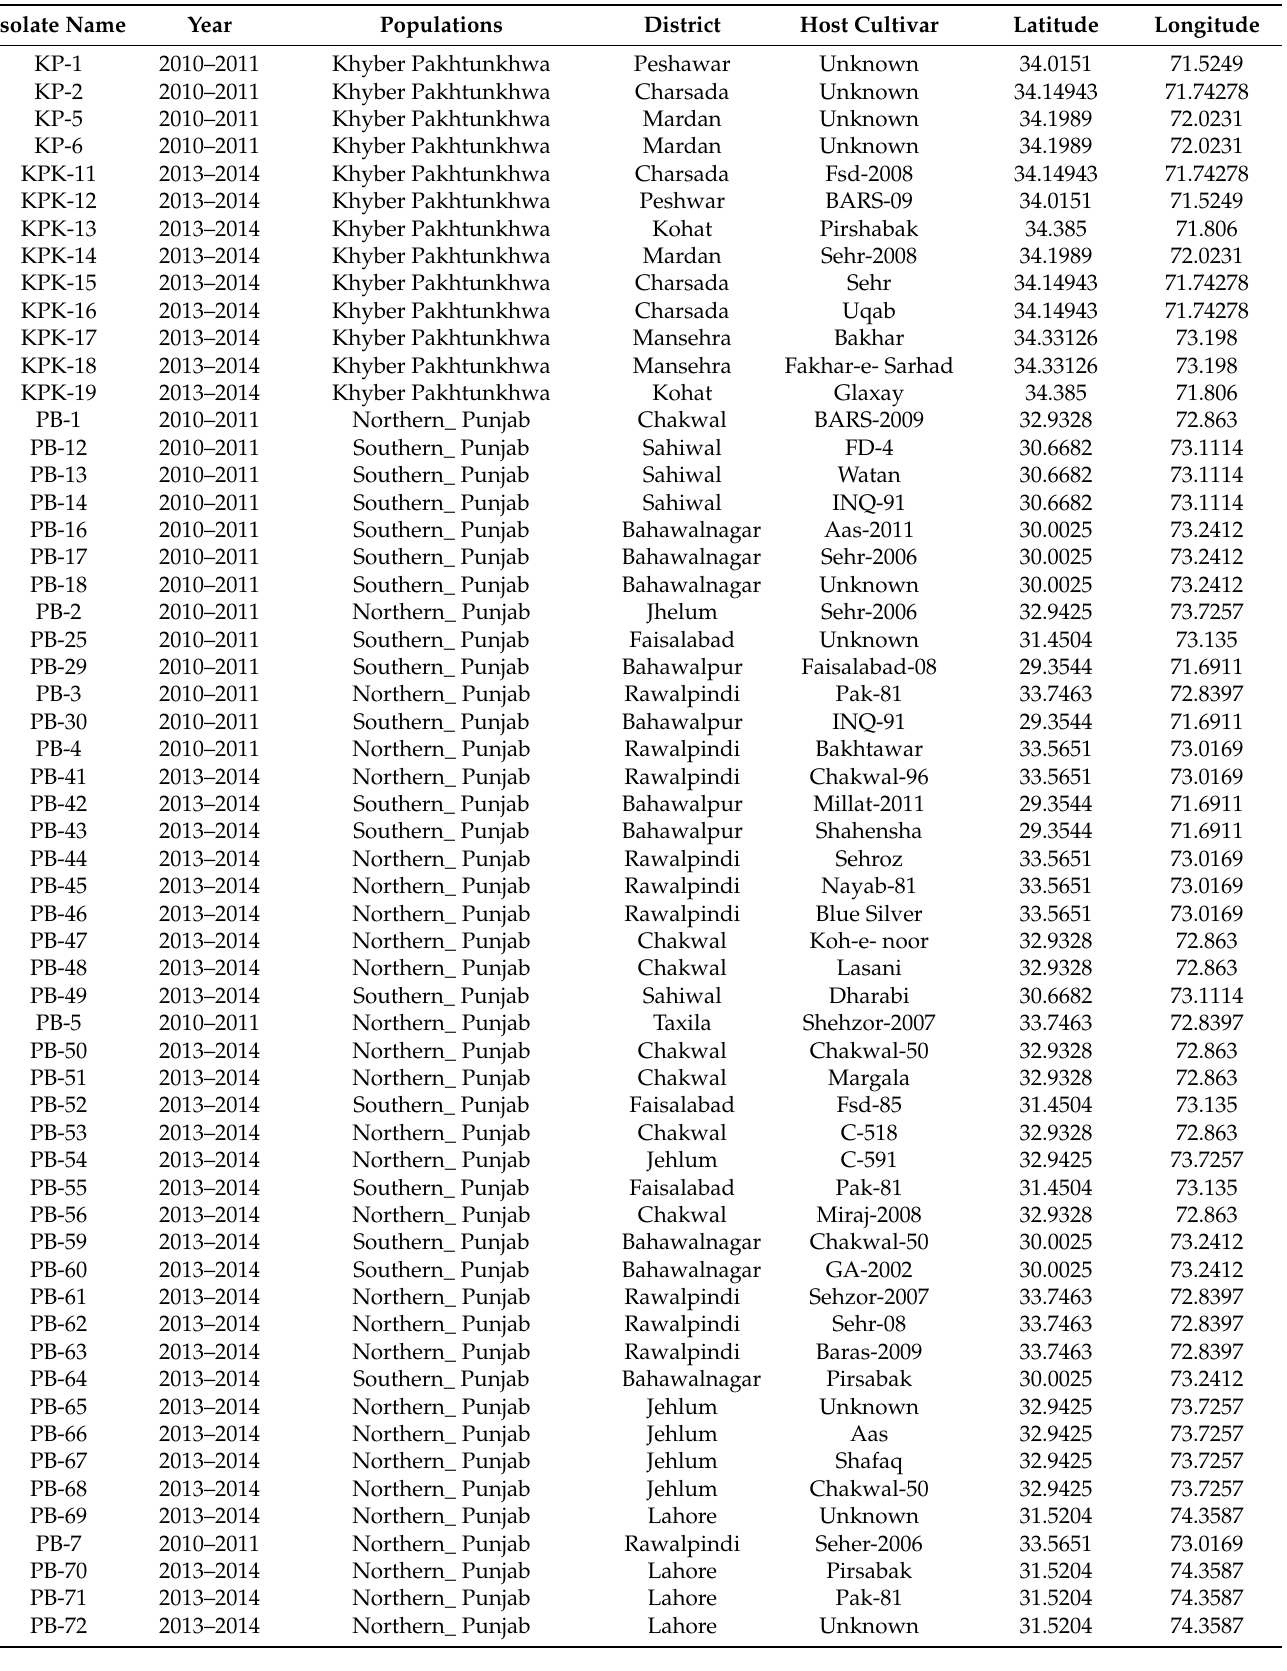
Table 1. Isolates of T. indica collected form Punjab and Khyber Pakhtunkhwa (KPK) during 2010–2011 and